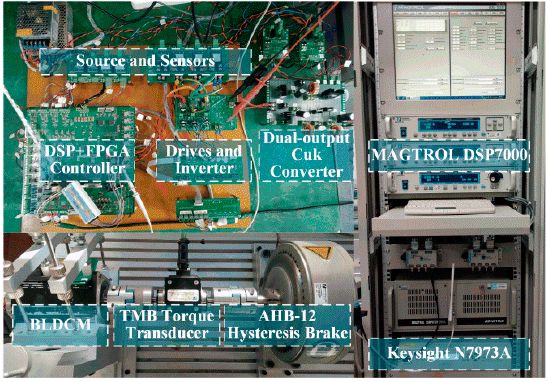
Figure 9. The experimental system. Table 1. The parameters of the motor.